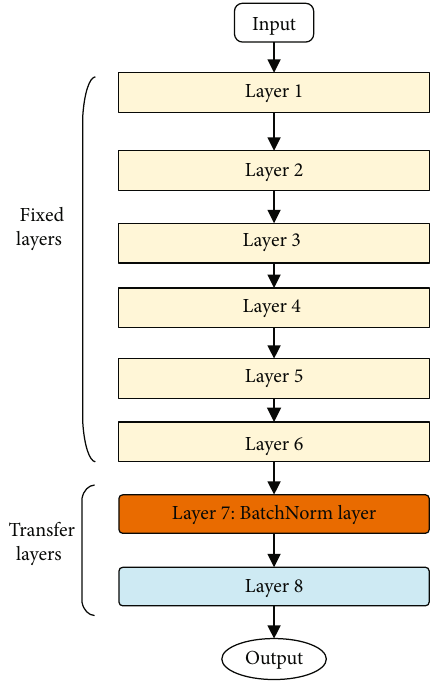
Figure 6: Architecture of the DTL network used in our